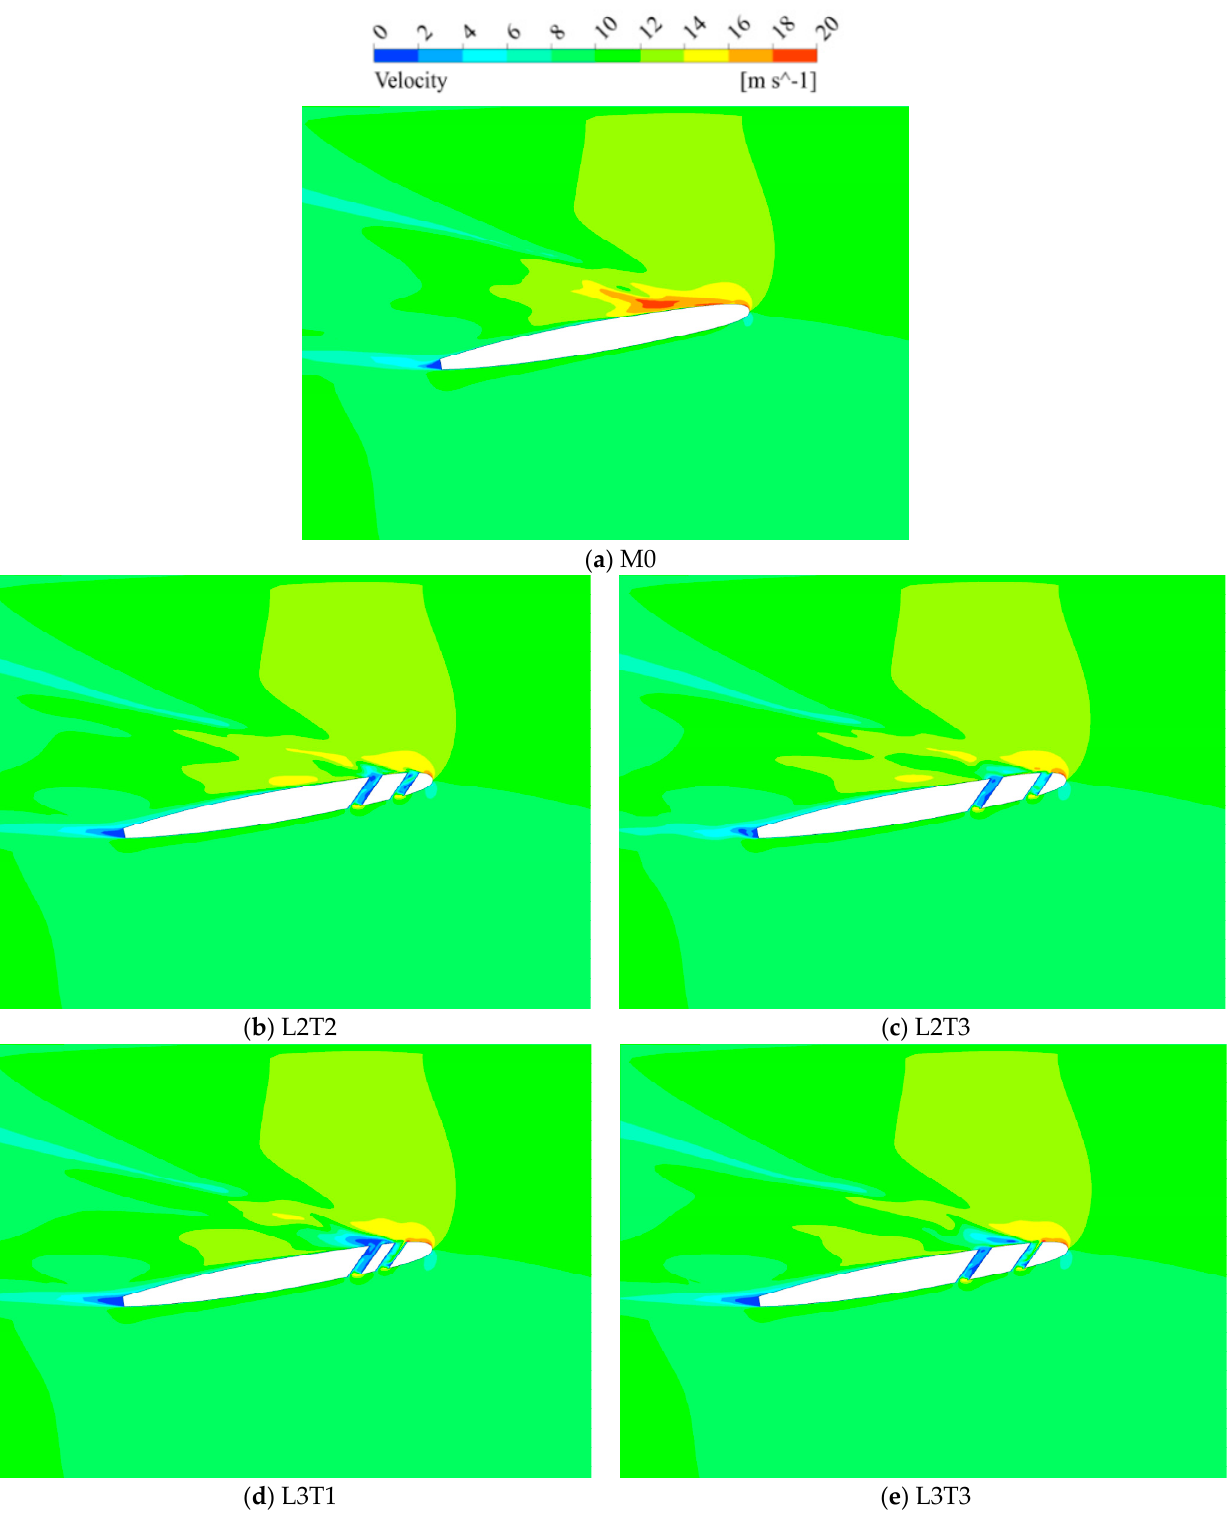
Figure 10. Velocity distribution for different schemes.